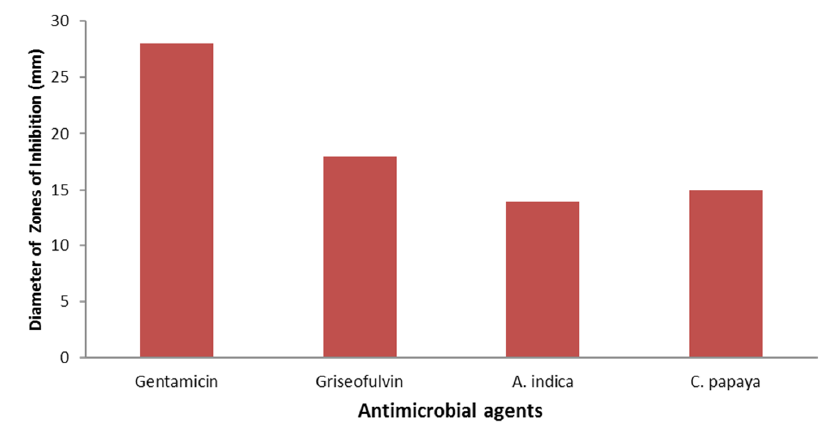
Figure 4. Comparison between highest effects produced by plant extracts and the commercial drugs Chromatogram of hexane extracts of C. papaya leaves as visualized in the form of peak showed six fractions of compounds namely: acacic acid, genistein, protodioscin, creptolephone, brusatol and alpha ionone. These compounds separated based on their unique chemistry; the peaks had the heights of 28.070,